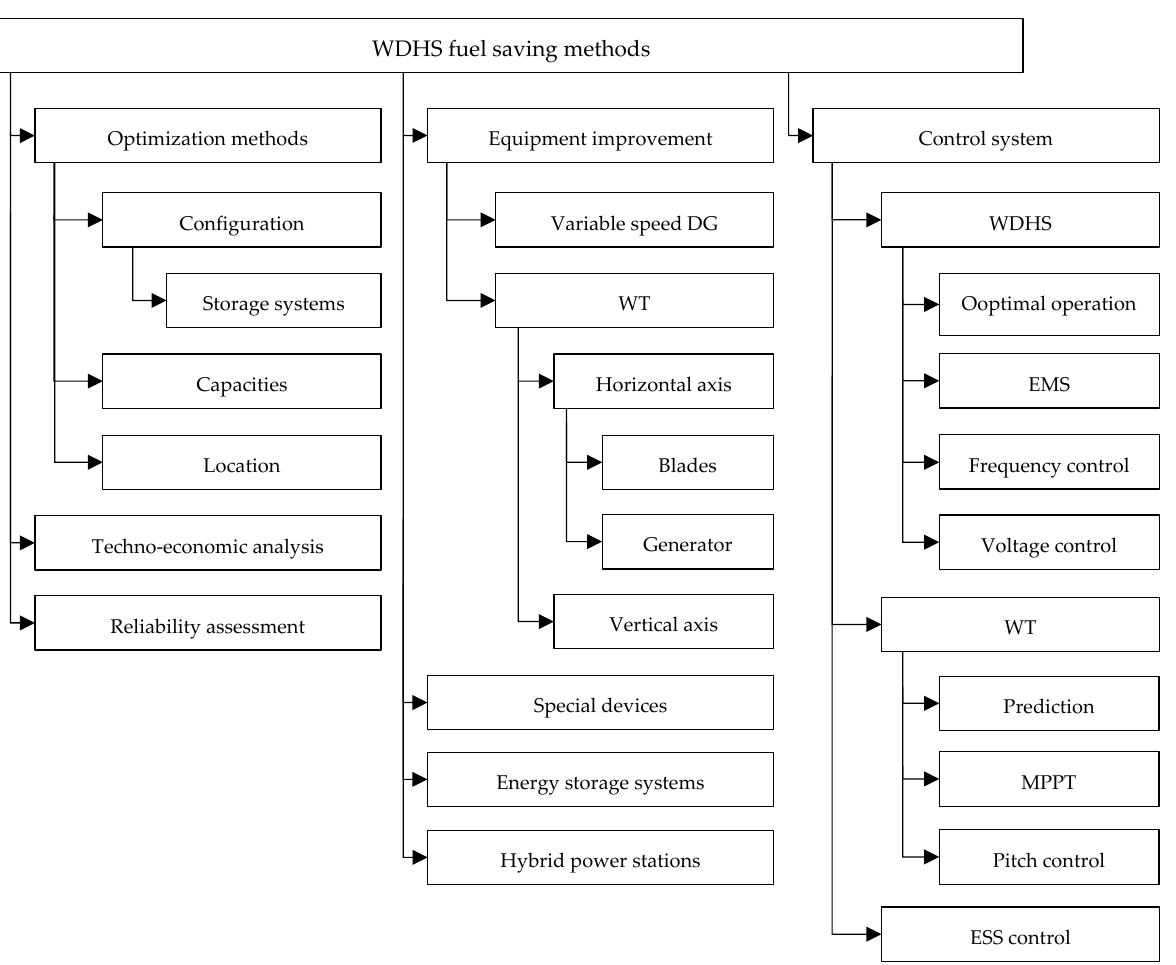
Figure 1. WDHS diesel fuel saving methods.